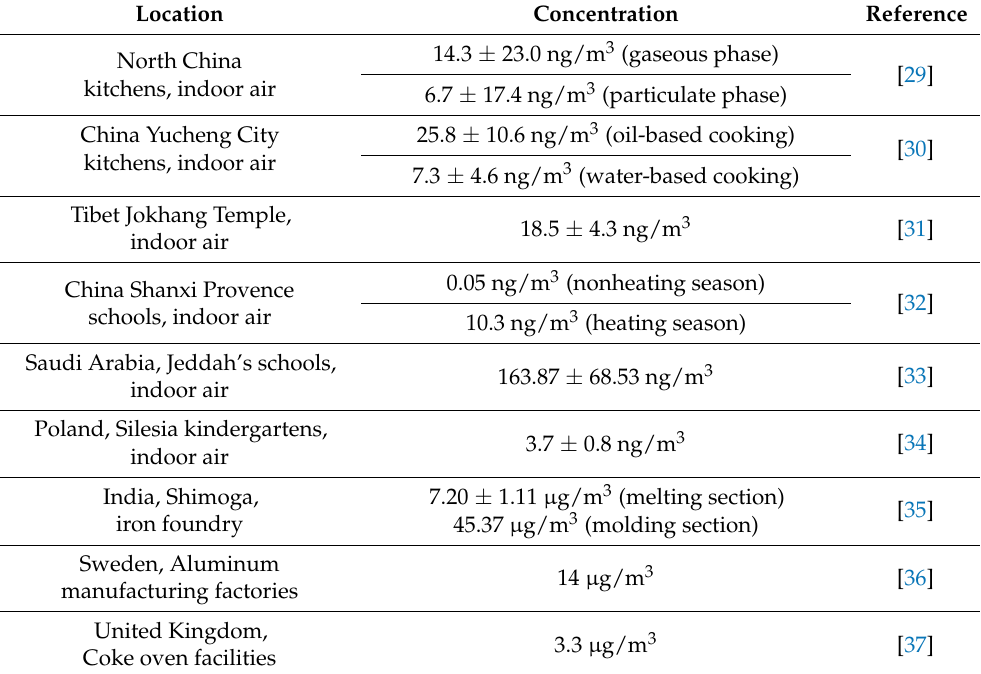
Table 2. B[ a ]P levels in indoor